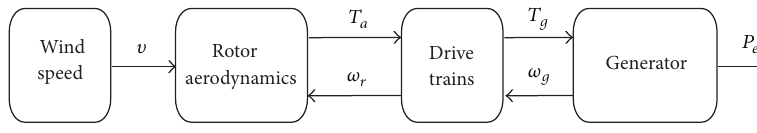
Figure 3: Schematic of WT.